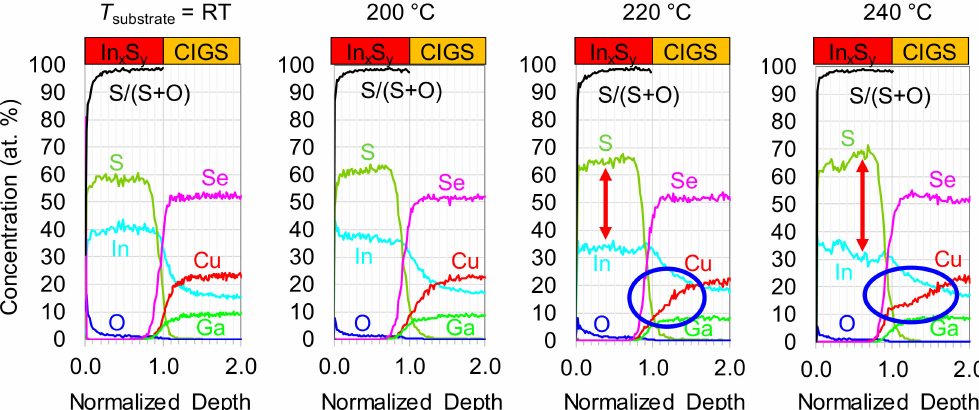
Figure 4. Quantified ToF-SIMS depth profiles performed with cesium cluster source for sputtering on In x S y / CIGS samples deposited at di ff erent substrate temperatures ( T substrate ) during In x S y sputtering. The x-axes are normalized for clarity. Nominal thickness of In x S y layers is 60 nm and sputtering inside CIGS was carried out within the first 100 nm. Changes in In x S y chemical composition are highlighted with red arrows and copper depletion of CIGS absorber is marked with blue circles.